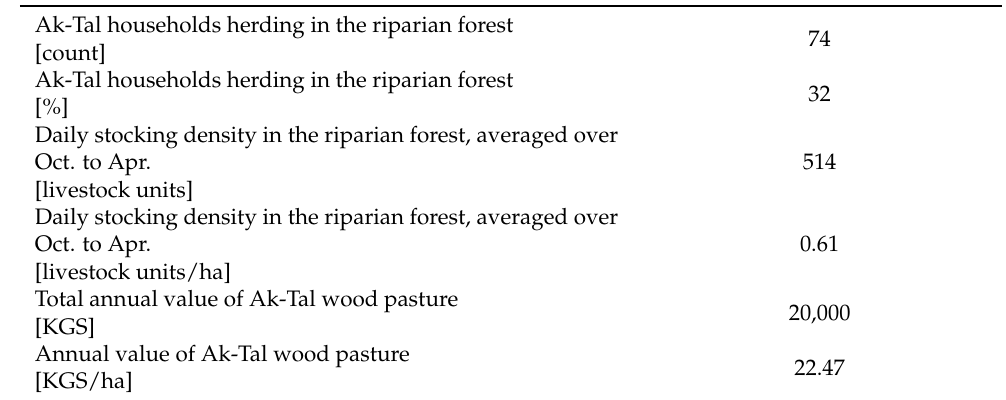
Table 3. Projected overall extent of riparian forest grazing, stocking density (Ak-Tal HHS 2020), and annual value of the pasture (FGD 2 2019) in Ak-Tal